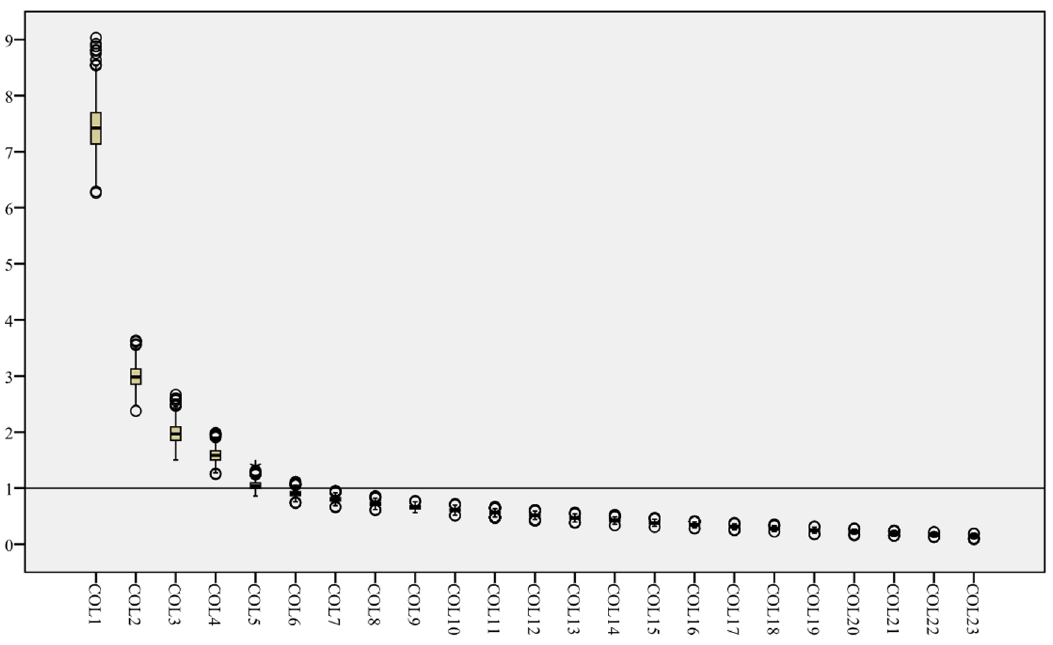
Figure 1. Empirically estimated sampling distribution of the 23